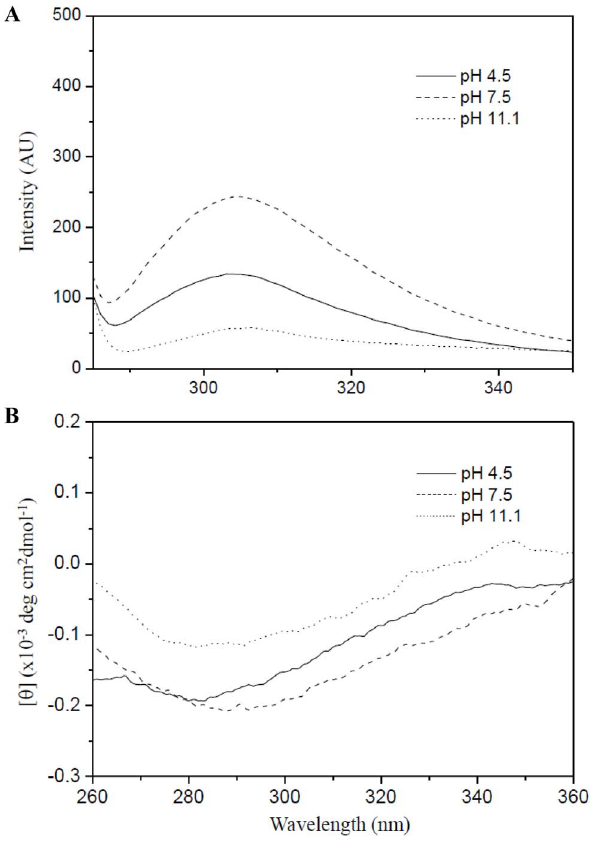
Figure 2. pH-dependent fluorescence and near-UV CD spectra of the ESD. The signals were measured at pH 4.5 (solid line), 7.5 (dashed line), and 10.0 (dotted line). The excitation wavelength was 277 nm. ( A ) and ( B ) denote fluorescence and near-UV CD spectra, respectively.